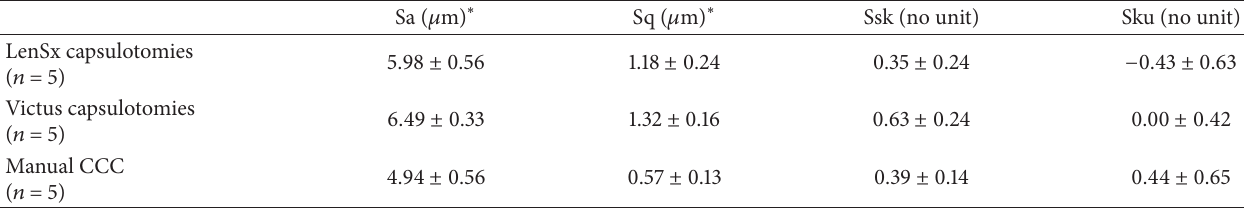
Table 1: Irregularity analysis (mean ± SD) of the FS laser capsulotomy and manual CCC cutting